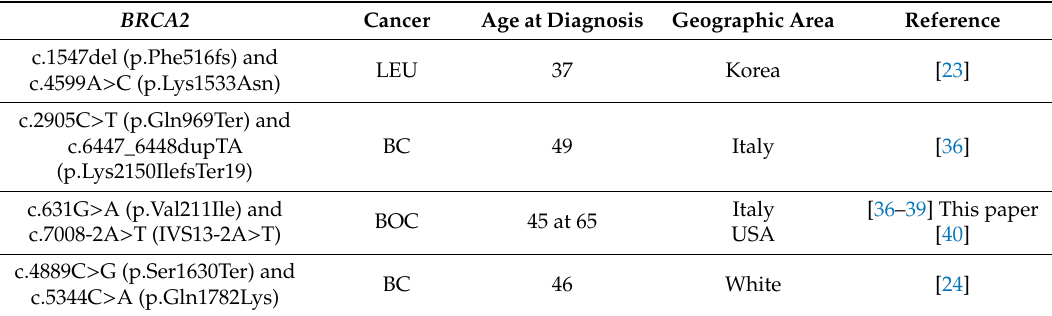
Table 7. BRCA2 DM reported worldwide (ClinVar